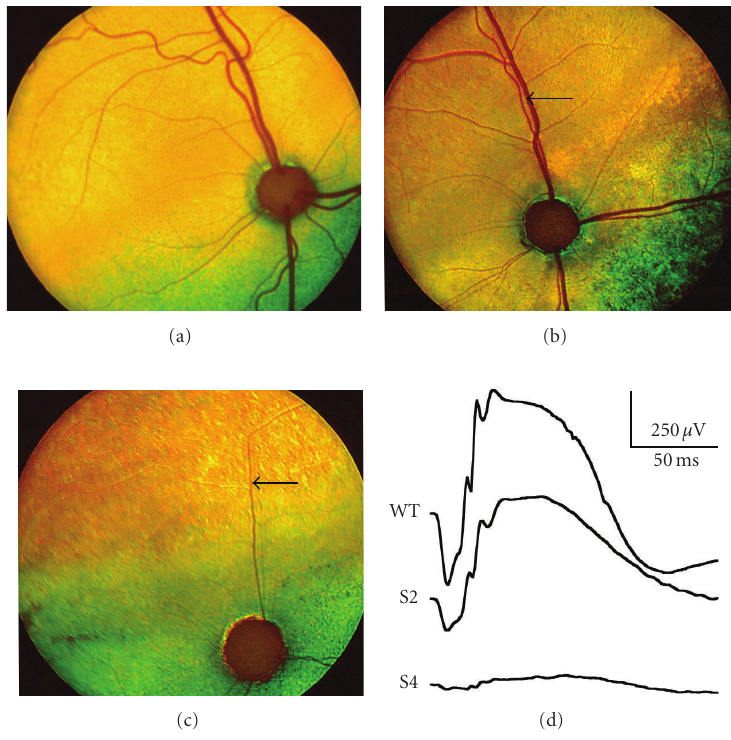
Figure 1: Fundus appearance and electroretinograms (ERGs) of rdAc individuals with the CEP290 mutation. Fundus photographs demon- strate (a) a 1-year-old una ff ected Abyssinian cat (wildtype, WT), (b) a 2-year-old a ff ected Abyssinian cat with an early disease stage (S2) [39], and (c) a 6-year-old Abyssinian with an advanced disease stage (S4) [39]. Arrows in (b) and (c) indicate retinal vasculature that is attenuated, more so in the advanced stage (c) than in early stage of disease (b). For the same three cats, the waveforms of the dark-adapted full-field flash ERG recordings are shown, using 4cd.s/m 2 of white light stimulation for each of the recordings. Amplitude and implicit time calibrations are indicated in the figure, vertically and horizontally, respectively. Reproduced with permission from [43].